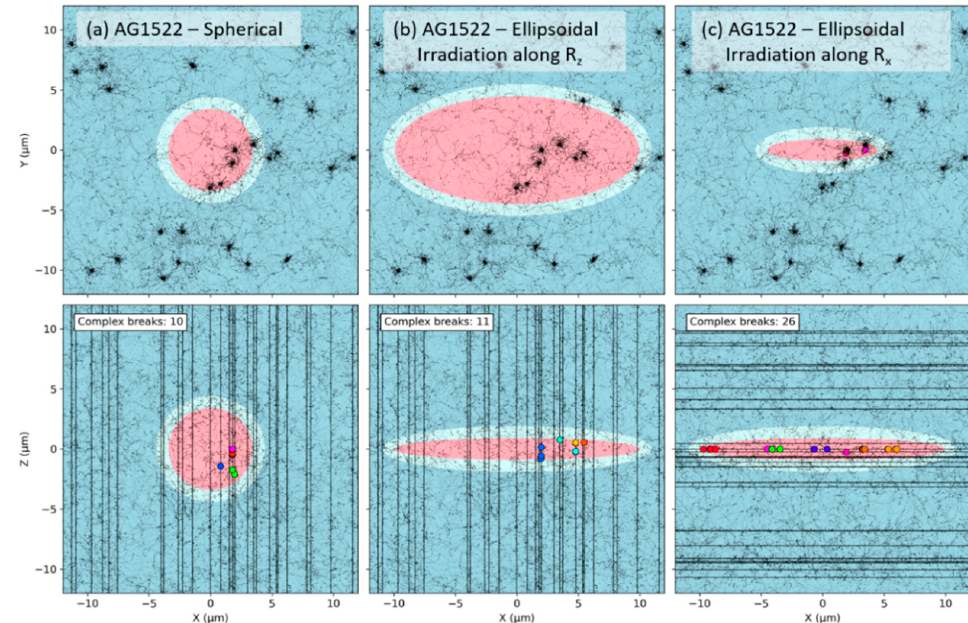
Figure 13. Projected track structure (black dots and lines) and complex DSBs (colored circles) before repair, for a Si 170 MeV/n Si irradiation (LET 99 keV/ μ m) and dose of 0.5 Gy. Views are shown from atop the beam line (top) and side (bottom). The disks represent the cell nucleus (pink) and cytoplasm (cyan), embedded in water (blue). Results are shown for the AG1522 fibroblast (V = 162 μ m 3 ) and without chromosome domain constraint, for ( a ) a spherical shape, and an ellipsoidal shape irradiated along ( b ) the thinner axis, and ( c ) along the longest axis. The different colors of the DSBs represent distinct chromosomes.